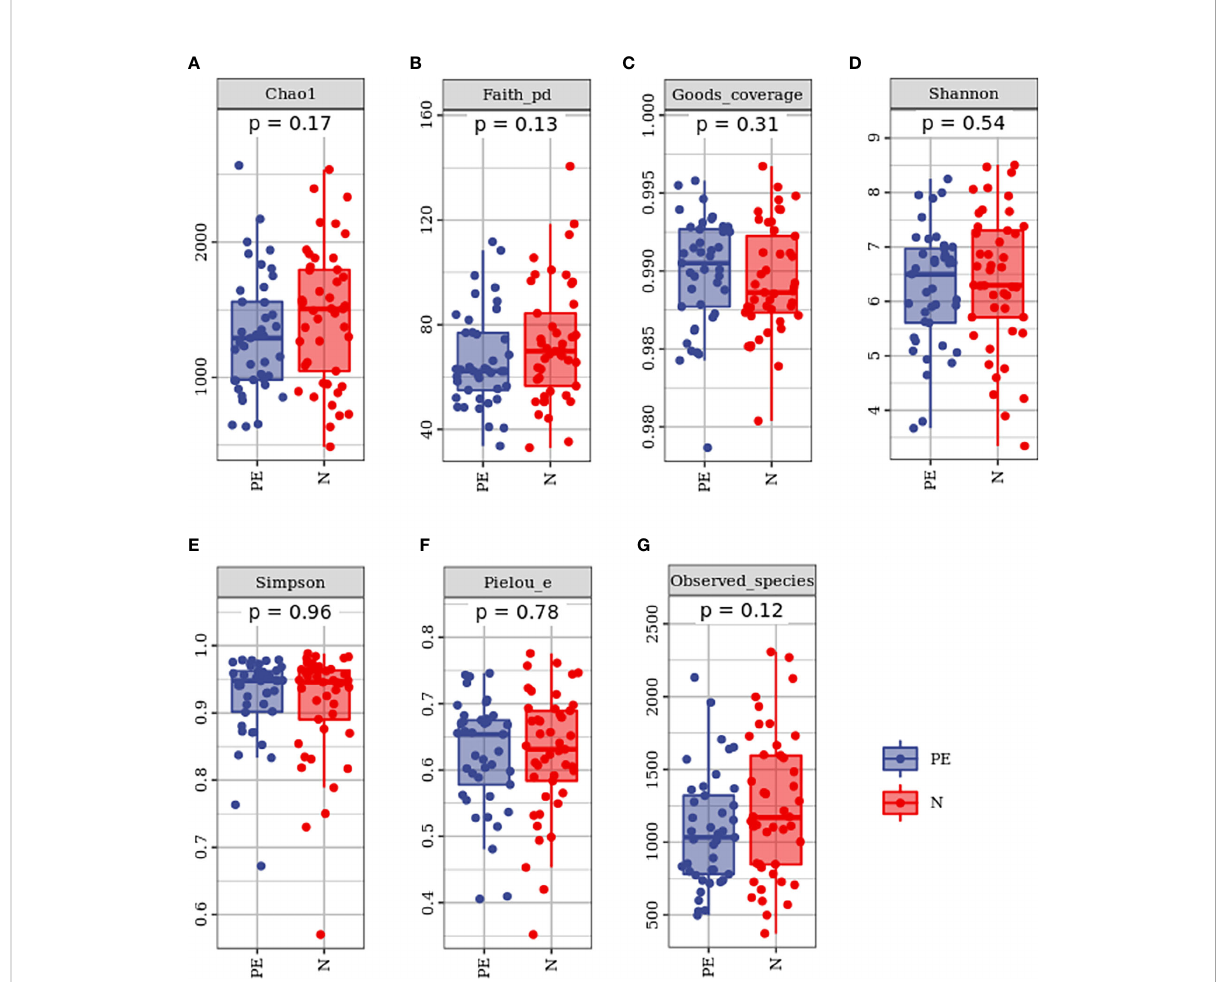
FIGURE 2 Varying alpha diversity of gut microbiota in the two groups. Chao1 diversity index (A) , Faith-PD (B) , Goods coverage (C) , Shannon diversity index (D) , Simpson diversity index (E) , Pielou-e (F) , and Observed species (G) in the PE group were lower than those in the normal group with no signi fi cant differences. PE, preeclampsia; N, the normal group.